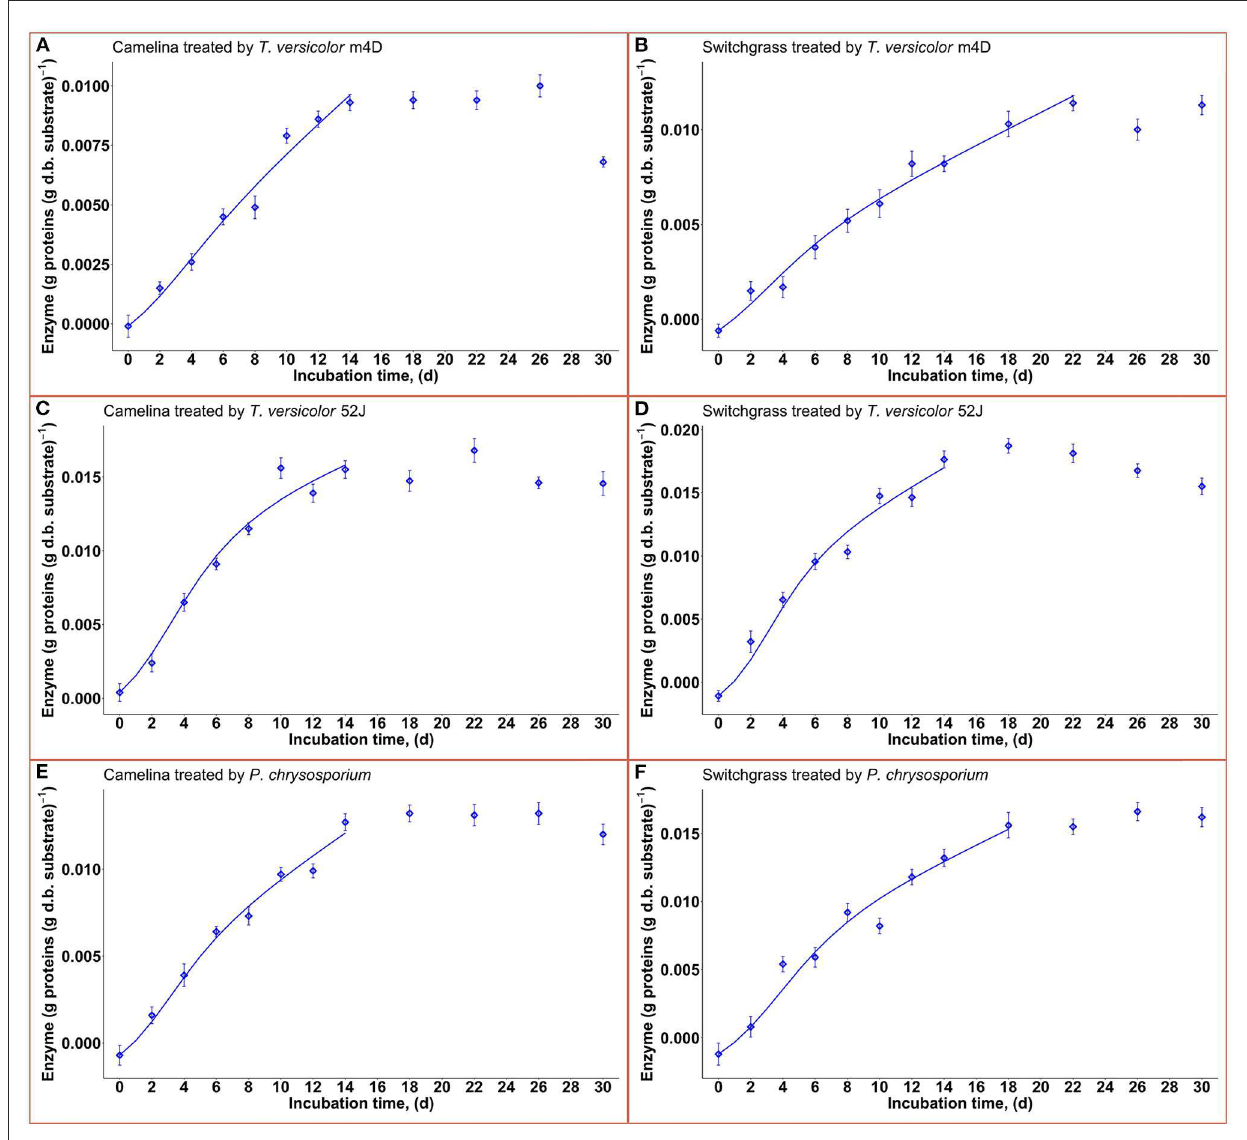
FIGURE8 Time profiles of enzyme production rate during 30 d of microbial pretreatment: (A) : profiles of TVm4D on CS, (B) : profiles of TVm4D on SG, (C) : profiles of TV52J on CS, (D) : profiles of TV52J on SG, (E) : profiles of PC on CS, (F) : Profiles of PC on SG; The continous lines were determined by the proposed